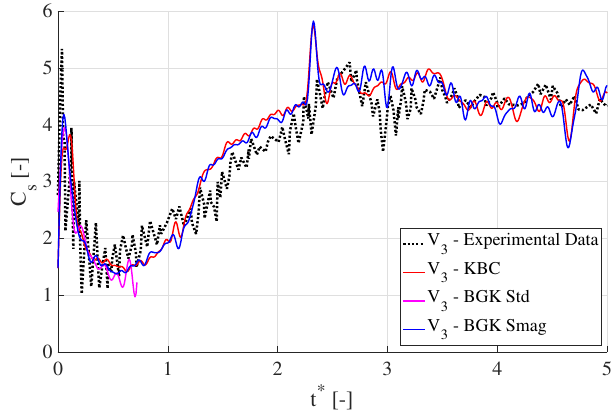
Figure 11. Comparison between experimental results presented by [32] and numerical model at Fr = 0.6865. Black dotted line represents experimental findings, solid red line the KBC results, magenta line the BGK without turbulence model, and the blue curve represents the BGK with Smagorinsky sub-grid model.